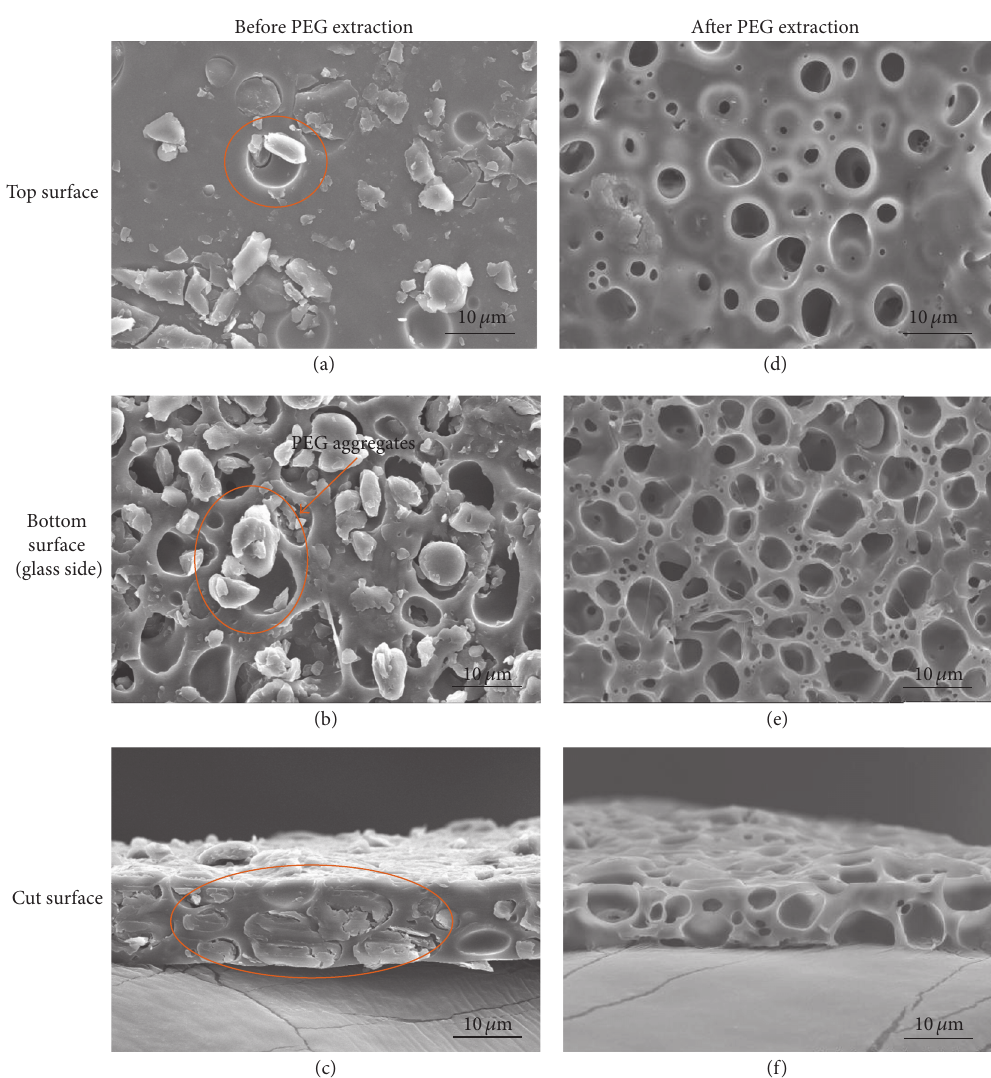
Figure 2: SEM images of the 50 PEG-PU composite film before (a–c) and after (d–f) the PEG extraction